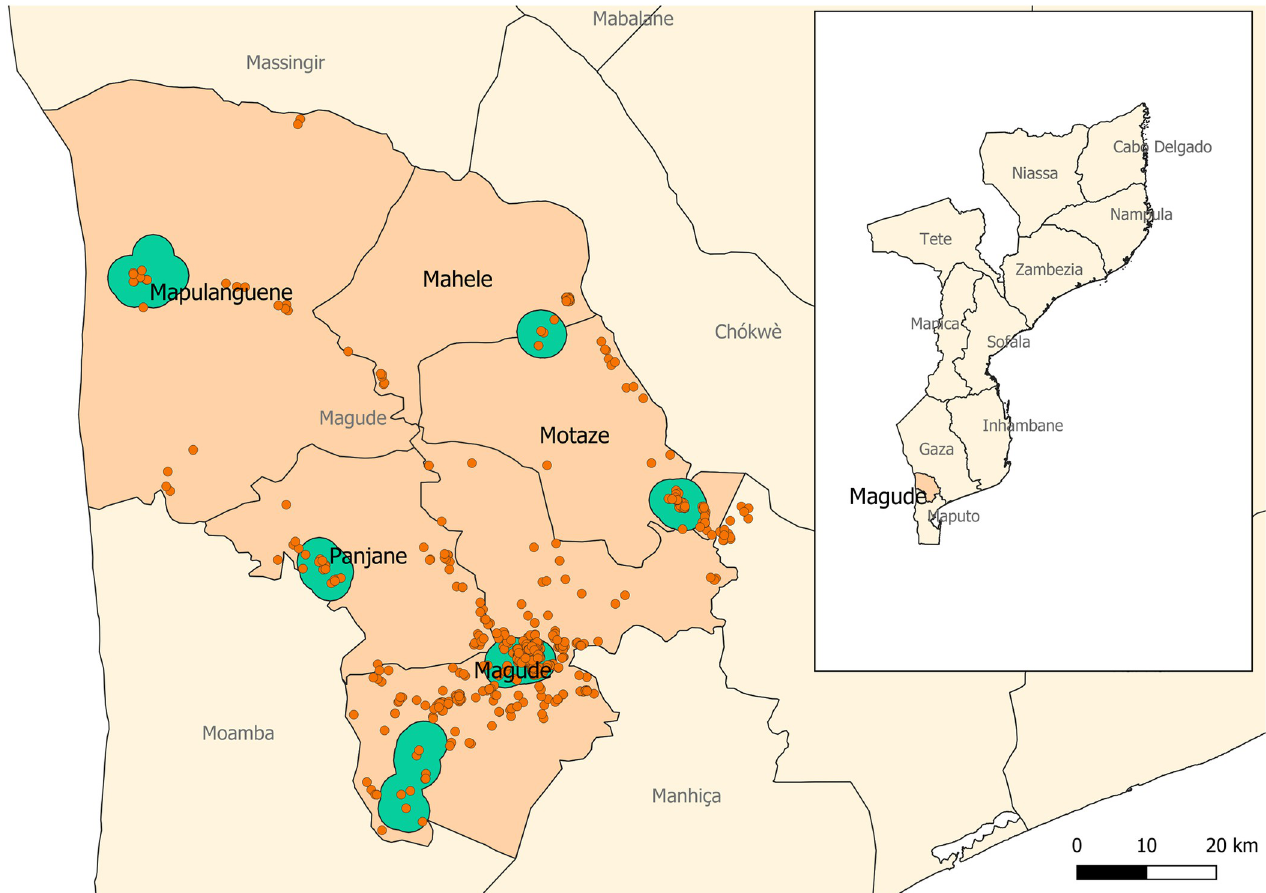
Fig 1. Map of Magude district. Red dots represent the households that were enrolled in the human behavioral study; the green areas are areas where entomological surveillance was conducted. The subnational administrative boundaries have been taken from the Humanitarian Data Exchange (https://data. humdata.org/dataset/cod-ab-moz) under a CC-BY-IGO license (https://data.humdata.org/faqs/licenses).